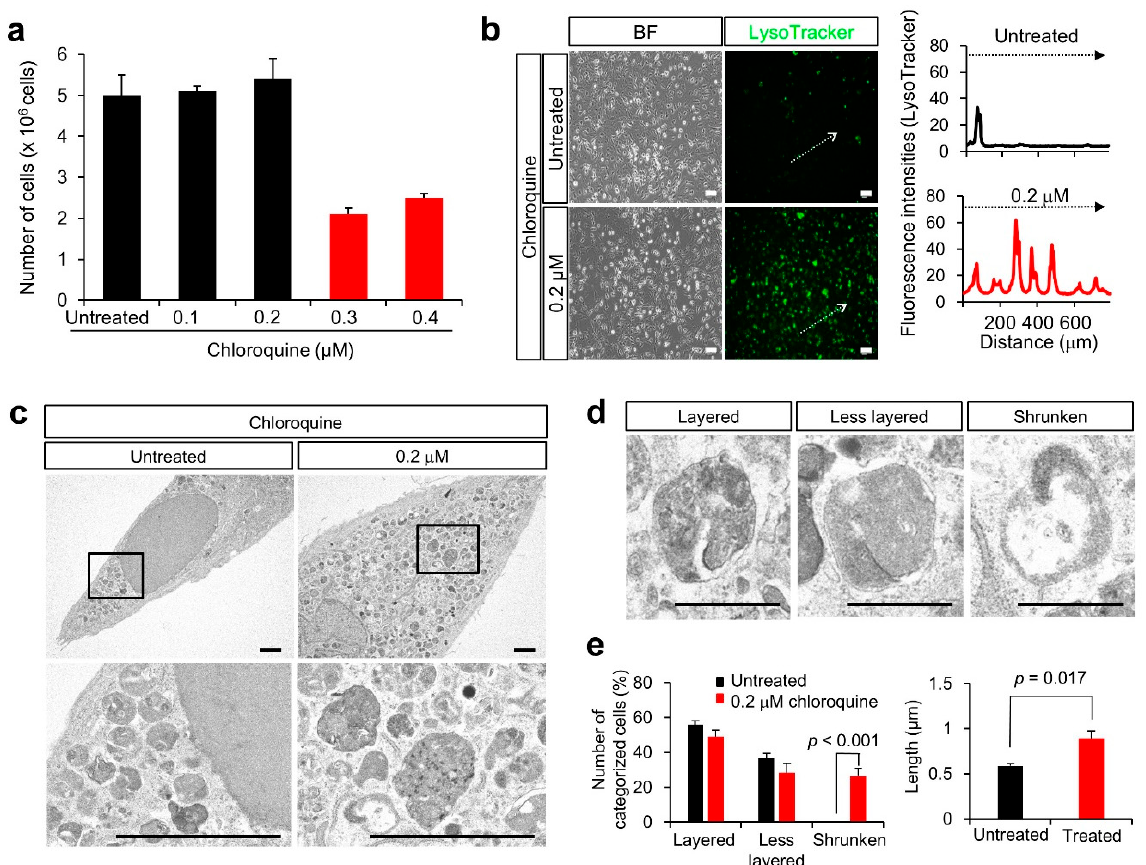
Figure 3. Effect of chloroquine treatment in KGN cells. ( a ) Number of KGN cells after dose-dependent chloroquine treatment (black bars; Untreated, 0.1, and 0.2 μ M, red bar; 0.3 and 0.4 μ M). Values are indicated as the mean ± SE. ( b ) Staining with LysoTracker and fluorescence intensity. The fluorescence intensity in areas marked with dotted arrows was measured. BF, Bright field. Scale bar, 50 μ m. ( c ) Electron microscopic images of KGN cells after chloroquine treatment. Scale bar, 2.5 μ m. The boxes are enlarged below. ( d ) Images of lysosomes. The lysosomes were categorized as layered, less layered, and shrunken. Scale bars, 0.5 μ m. ( e ) Number of lysosomes is categorized into three groups and measurement of the long axis of lysosomes (black bars; without chloroquine, red bar; with 0.2 μ M chloroquine). Values are indicated as the mean ± SE.